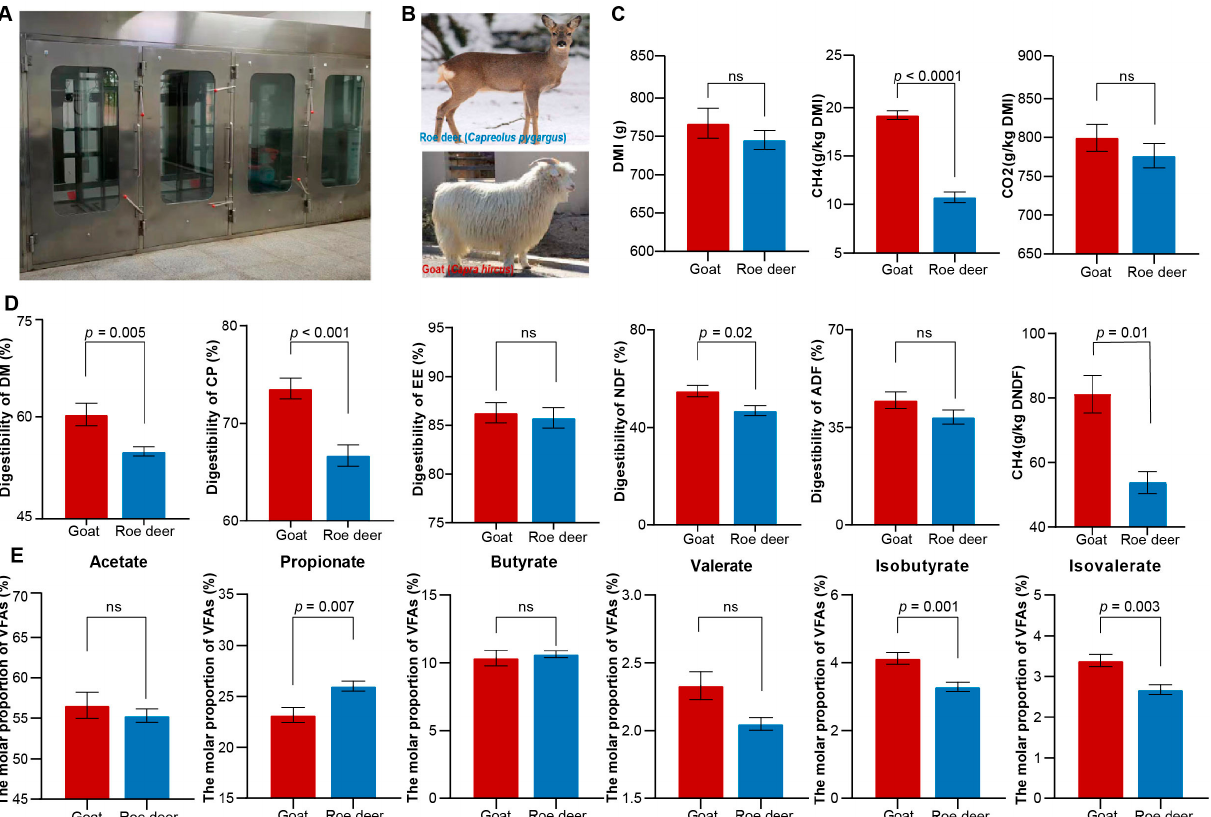
Figure 1. The measurement and comparison of gas yields, digestibility, and VFAs between roe deer and goats. ( A ) CH 4 and CO 2 yields from the roe deer and goats were measured using open-circuit respiration chambers; ( B ) roe deer and goats were used in the present study; ( C ) comparisons of dry matter intake (DMI), CH 4, and CO 2 (g/kg DMI) from roe deer and goats; ( D ) comparing digestibility of nutrients and methane production per kilogram of digested NDF between roe deer and goats; ( E ) the molar proportion of VFAs in feces of roe deer and goats. The p -value indicates the statistical significance of the differences. The significances were determined using the Mann–Whitney test based on the Benjamini–Hochberg corrected p -values; ns means no significant differences.